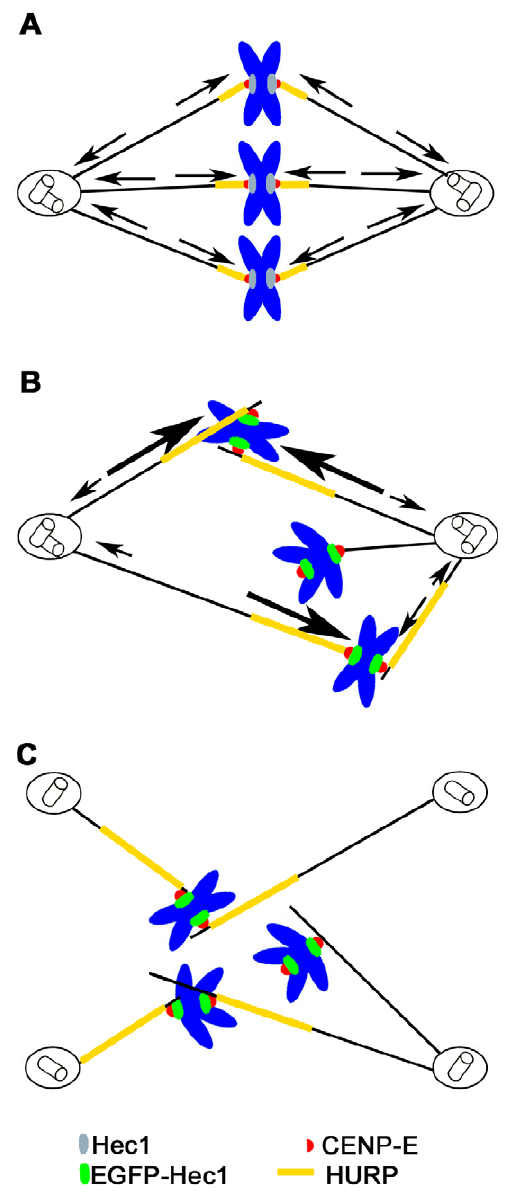
Figure 8. Schematic representation of the mechanism produc- ing centrosome fragmentation after EGFP-Hec1 expression. (A) Metaphase cell with balanced spindle forces (arrows). (B) EGFP-Hec1 expressing prometaphase cell. EGFP-Hec1 kinetochores (green) form lateral kinetochore-microtubule attachments that recruit more CENP-E (red) and HURP (yellow). CENP-E mediated plus-end directed forces (large arrows) overcomes the dynein-mediated minus-end forces (small arrows). (C) Kinetochore directed CENP-E mediated forces produce centrosome fragmentation and centriole splitting.